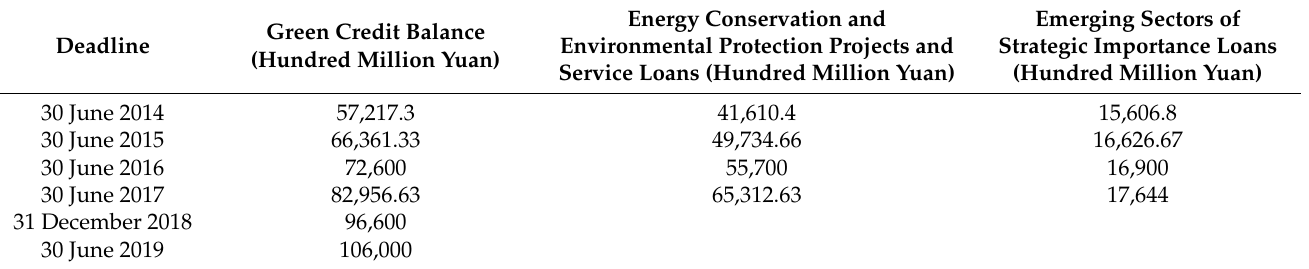
Emerging Sectors